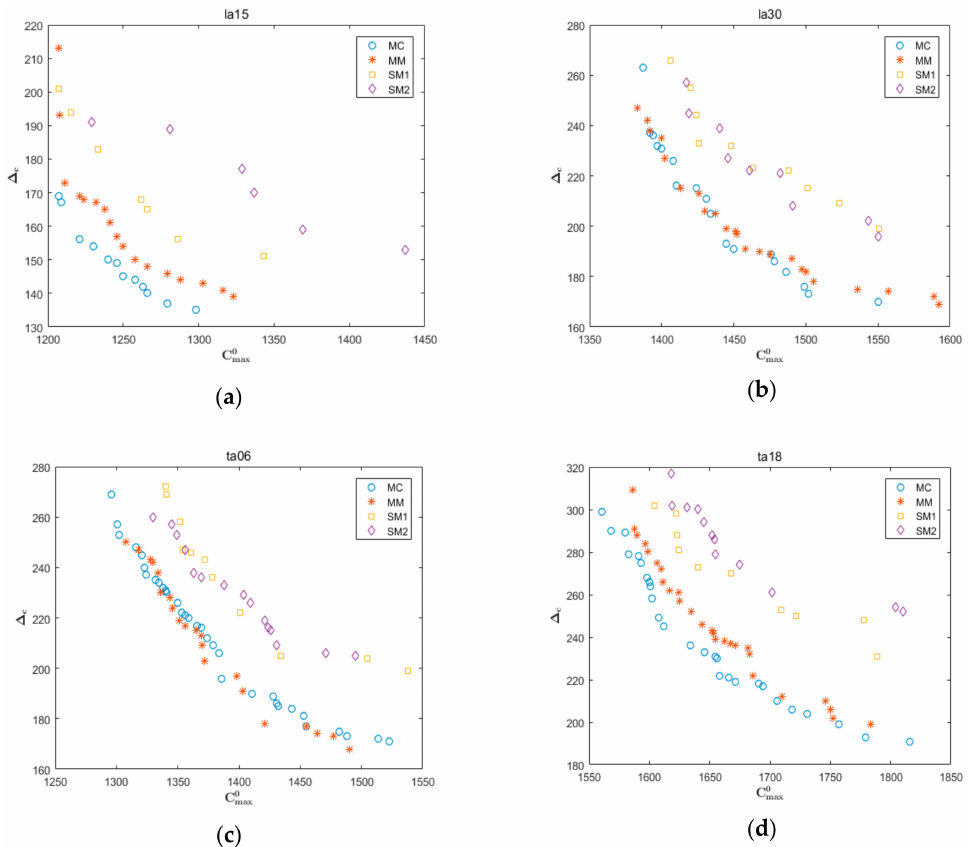
Figure 6. The Pareto fronts of algorithms MC, MM, SM1, and SM2. ( a ) For the problem La15; ( b ) for the problem La30; ( c ) for the problem Ta06; ( d ) for the problem